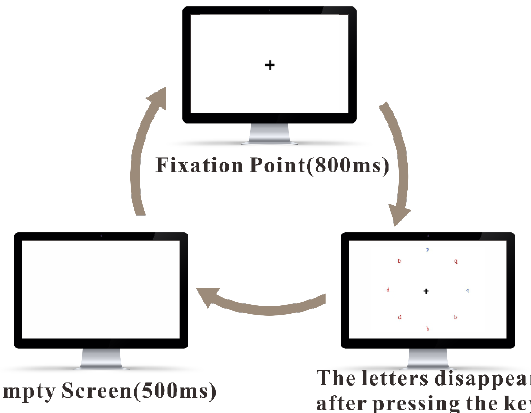
Figure 3. Visual search task experiment screen. When judging the color of the lowercase letter “p”, the volunteers were asked to press the “F” key if it was red; otherwise, press the “J” key.